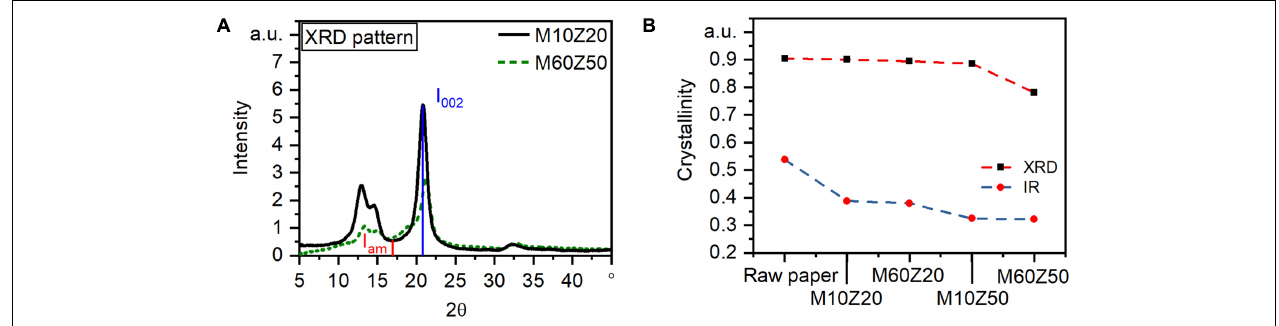
FIGURE 4 | (A) Determination of crystallinity exemplary on XRD pattern of Cottonid variant M10Z20, (B) Cristallinity determined on the base of IR spectra and XRD patterns for all Cottonid variants.